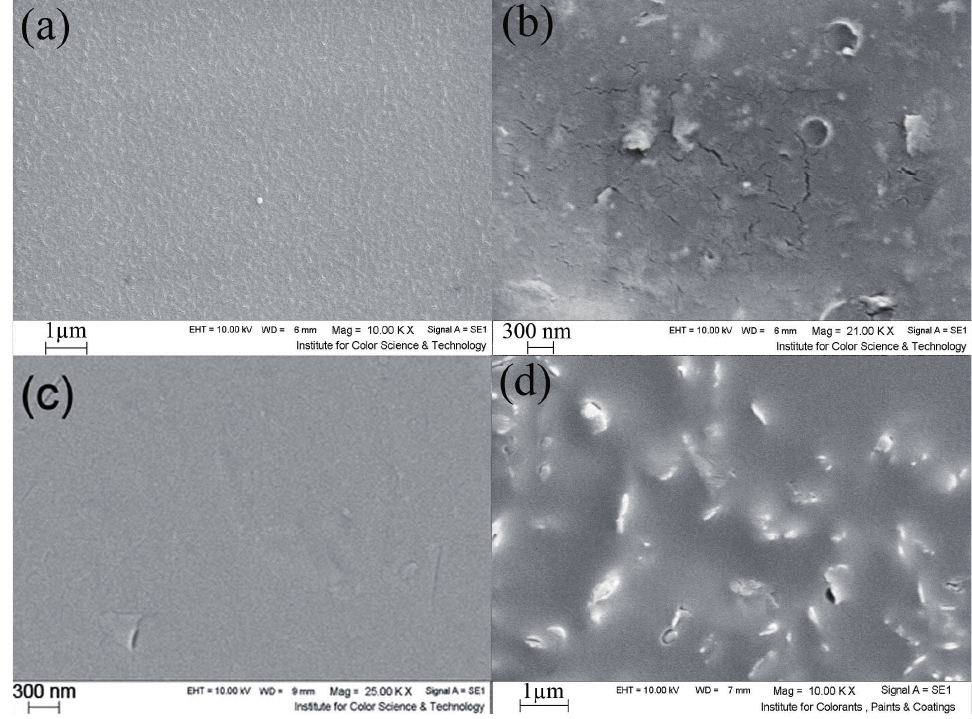
Figure 7. SEM images of (a) pure CA (b) CA/Sb 2 O 3 -Br (c) pure ABS (d) ABS/Sb 2 O 3 -Br